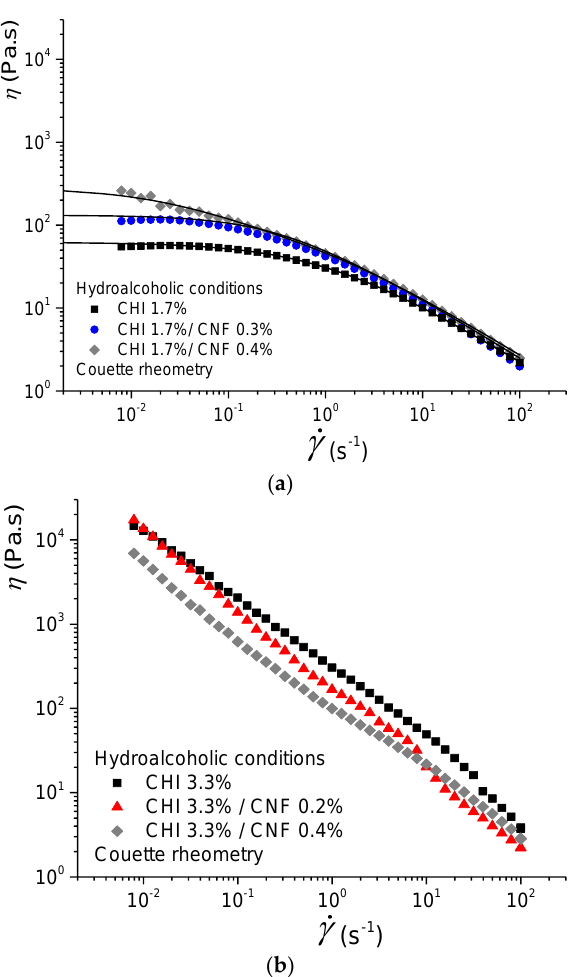
Figure 2. Evolution of viscosity η versus shear rate γ w obtained by Couette geometry for chitosan CHI solutions and cellulose nanofiber-filled chitosan CNF/CHI suspensions of ( a ) 1.7% and ( b ) 3.3% ( w / w ) chitosan, containing different CNF contents (0.2–0.4% ( w / w )) and obtained in hydroalcoholic conditions.